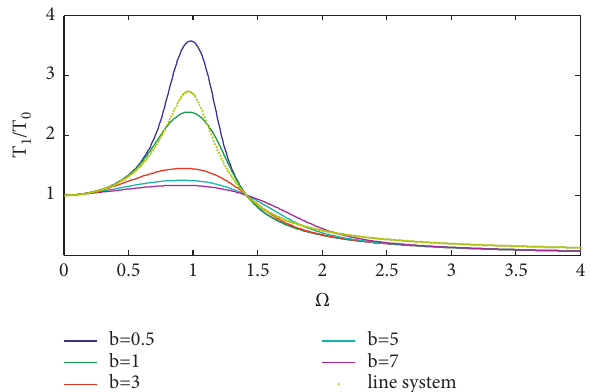
Figure 8: Force transmissibility-frequency ratio diagram for dif- ferent b